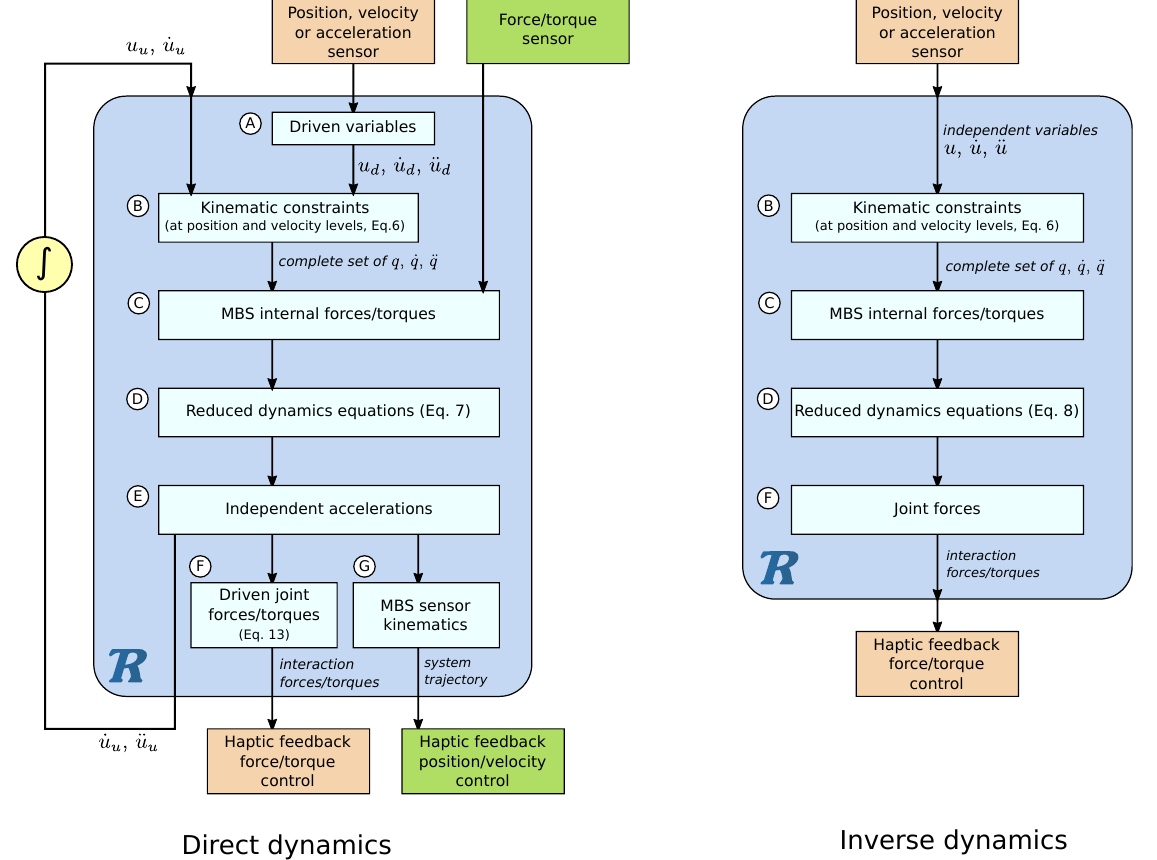
Figure 4. Flow diagram of direct and inverse dynamics in view of coupling them with haptic